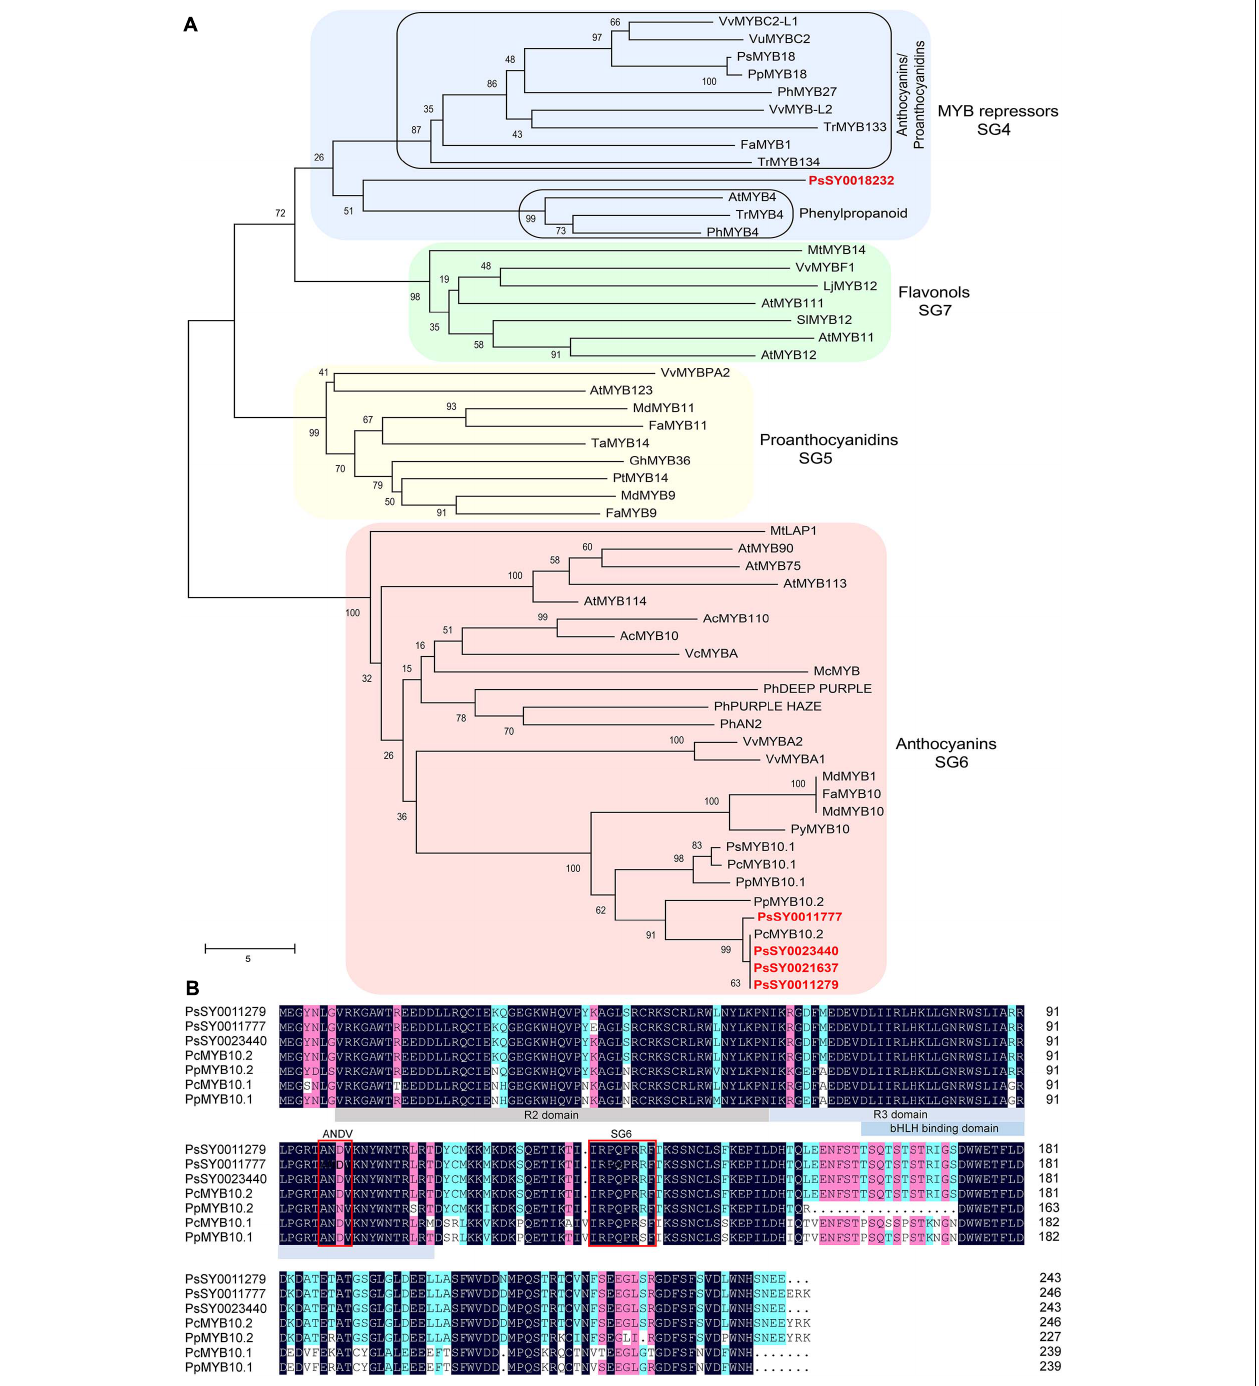
FIGURE 6 | Sequence analysis of selected R2R3 MYBs. (A) Phylogenetic analysis of PsMYBs and R2R3 MYBs from other plant species. Plum MYBs are indicated in red font. (B) Multiple sequence alignment of PsMYBs and R2R3 MYBs from peach and cherry plum. R2, R3, and bHLH binding domain are highlighted in gray and blue colors, conserved ‘ANDV’ and SG6 motif for anthocyanin-promoting MYBs are indicated in red boxes.